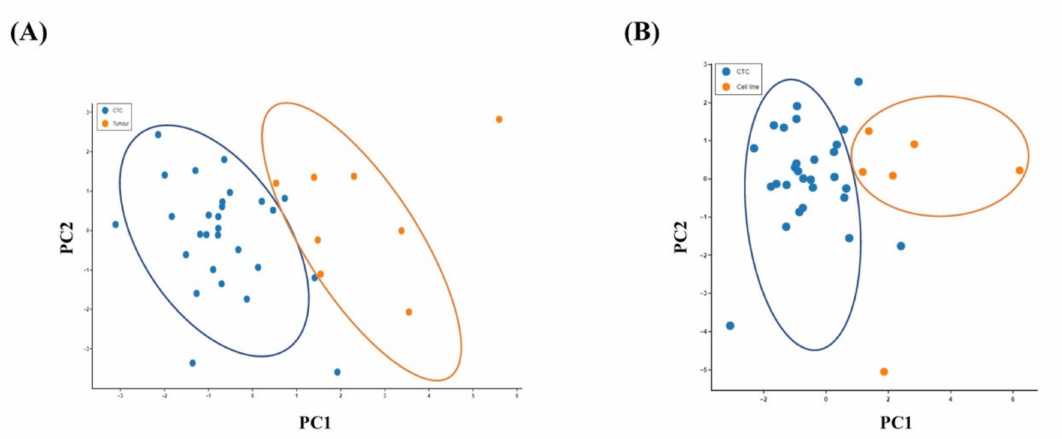
Figure 3. Relationship of the gene expressions of the CTCs with the primary carcinoma and the colon cancer cell lines. Principal component analysis (PCA) plot of the expression of 19 genes in ( A ) single CTCs and the primary carcinomas and ( B ) single CTCs and the colon cancer cells in cell